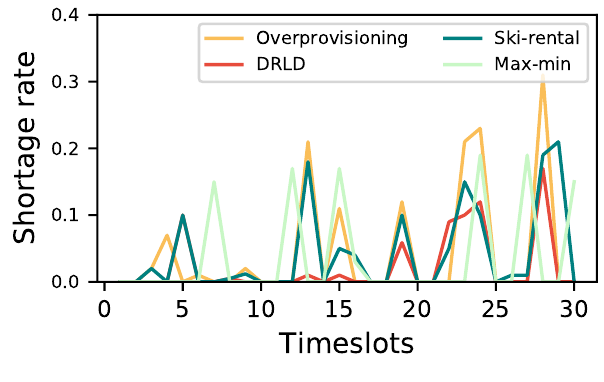
Figure 6. Shortage evaluation.